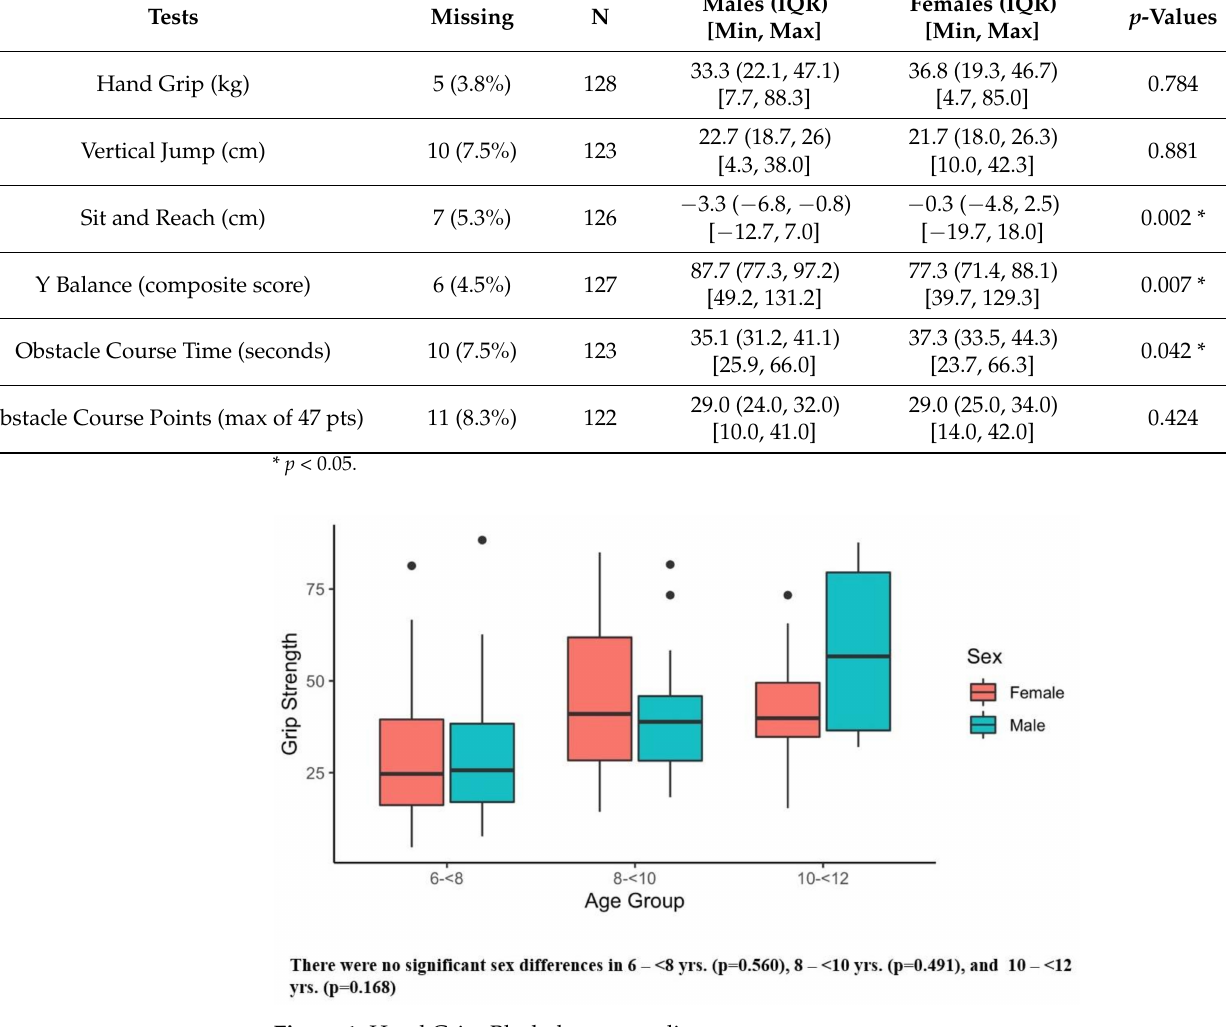
Figure 1. Hand Grip. Black dots are outliers.